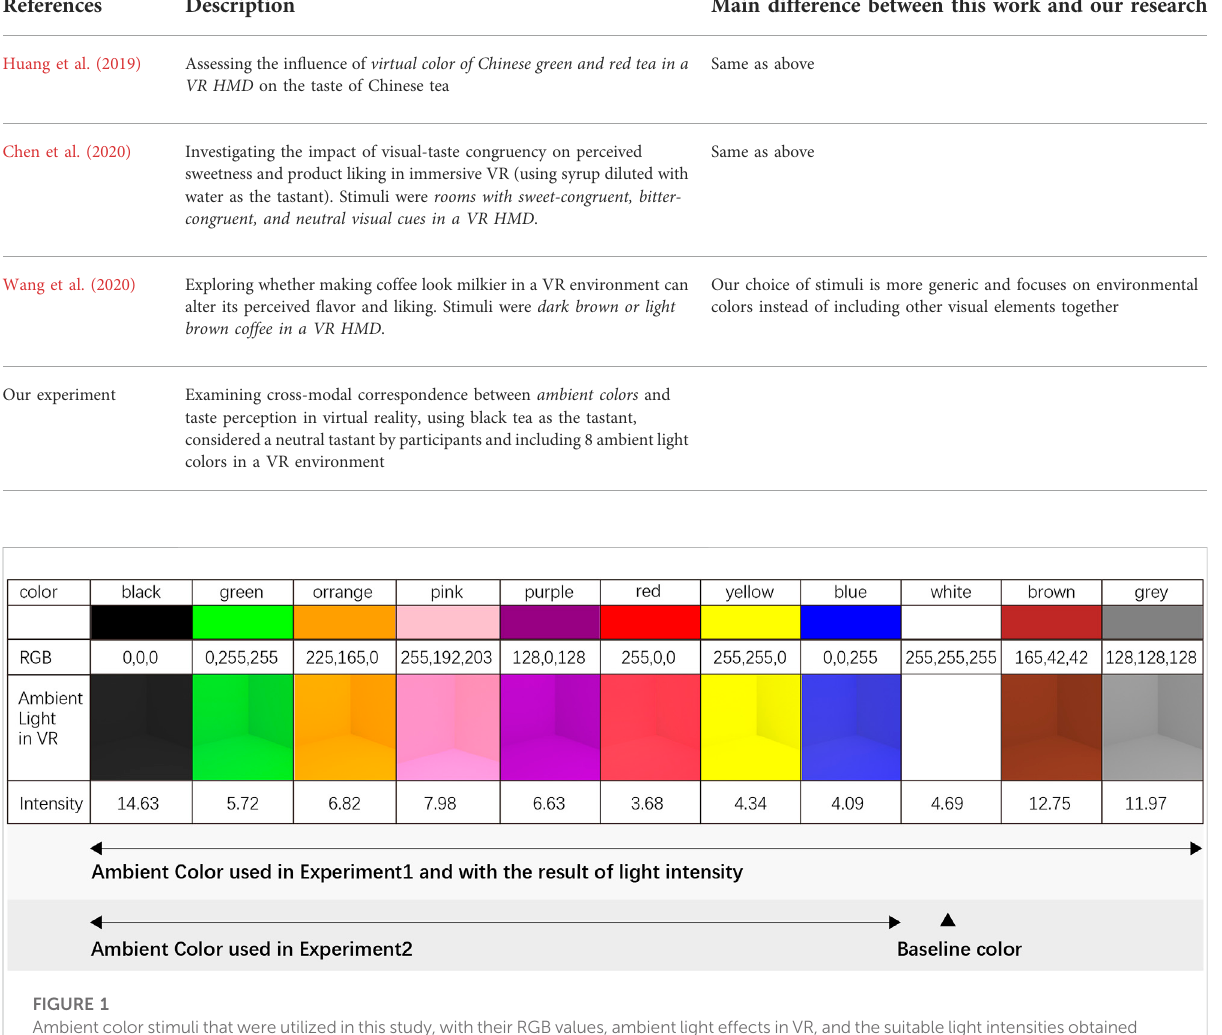
TABLE1( Continued )Asummaryofrelatedworkabouttasteandtheimmersiveenvironmentswiththeusedstimuli.Tastantsarehighlightedinboldand tested stimuli were marked in